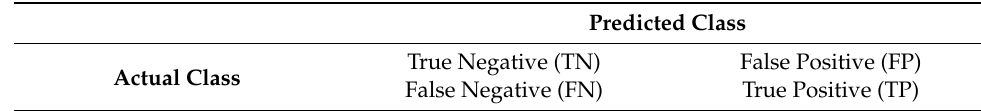
Table 2. Confusion matrix structure for binary classification